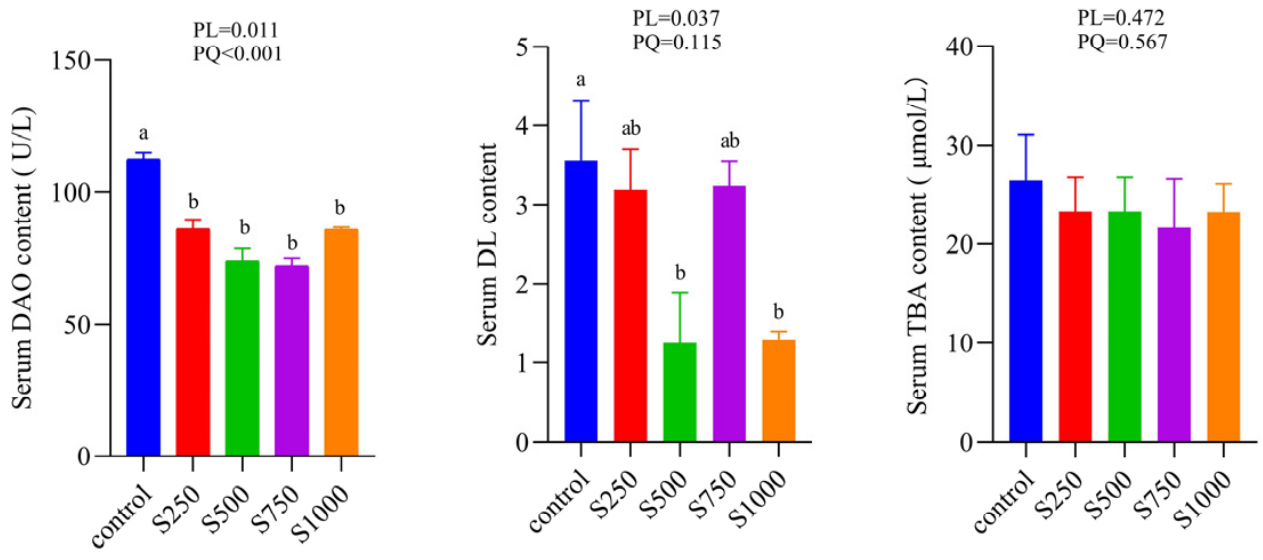
Figure 2. Effects of dietary CSB levels on serum biochemical indices ( n = 6). a,b Means without com- mon letters above the histogram differ significantly ( p < 0.05). DAO: Diamine oxidase, DL: D-lactic acid, TBA: Total bile acid.